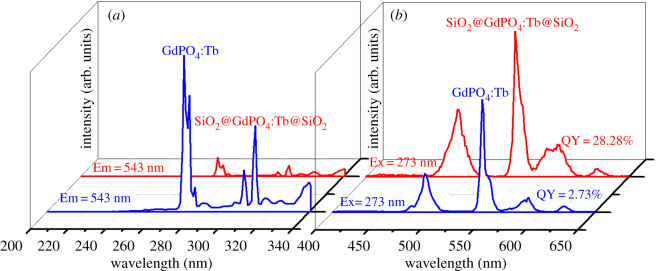
Excitation spectra (a) and emission spectra (b) of blue line (GdPO4:Tb) and red line (SiO2@GdPO4:Tb@SiO2).